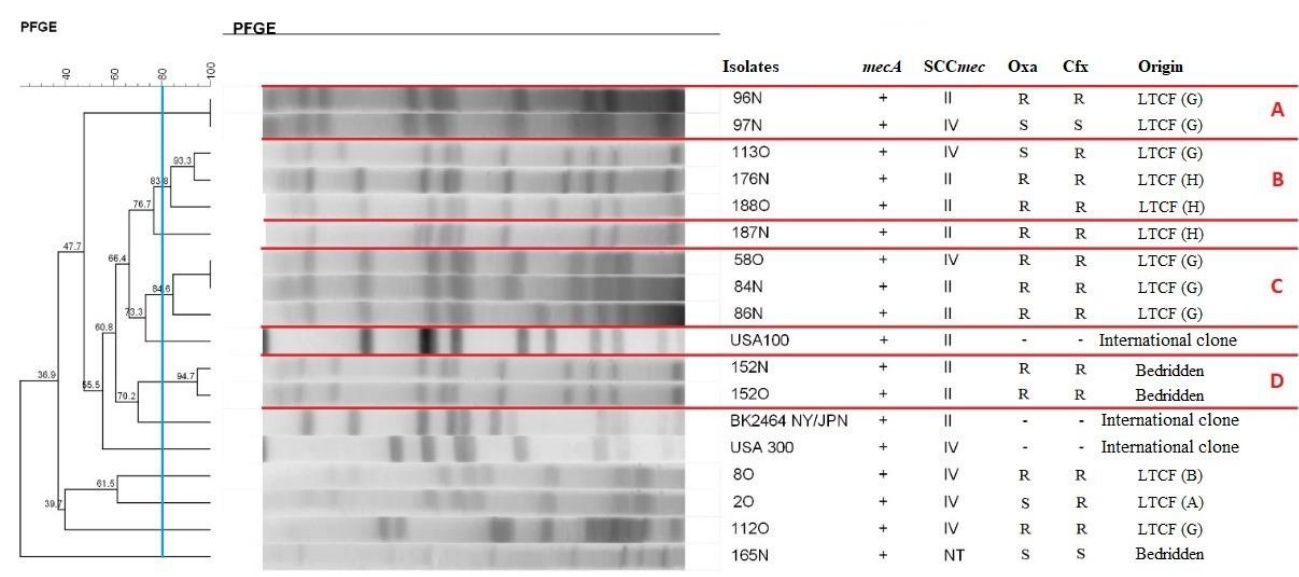
Figure 3. Dendrogram of PFGE-ApaI profiles of MRSA isolated from bedridden patients at home or